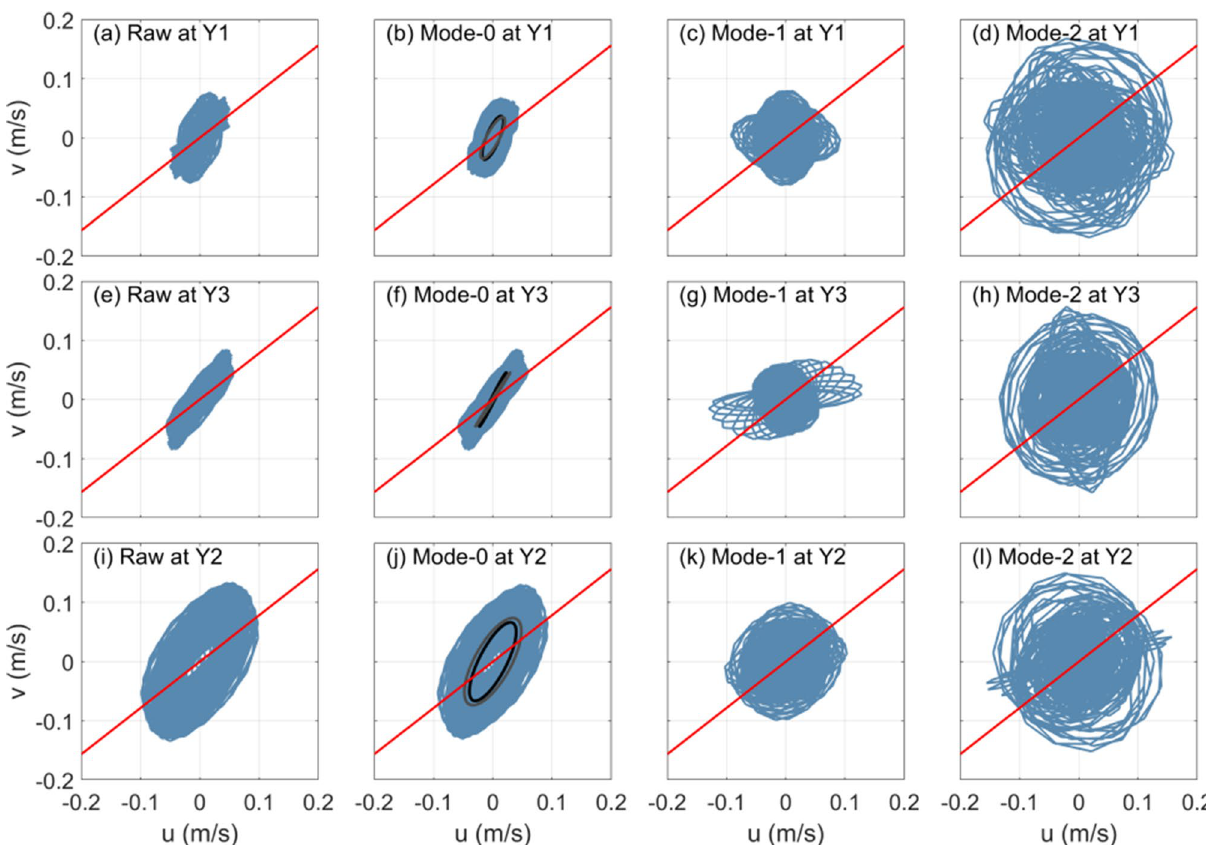
Figure 5. Same as (Fig. 3) but for semidiurnal currents. The black ellipses in ( b , f and j ) are the M 2 tidal ellipses extracted from Arc5km2018.